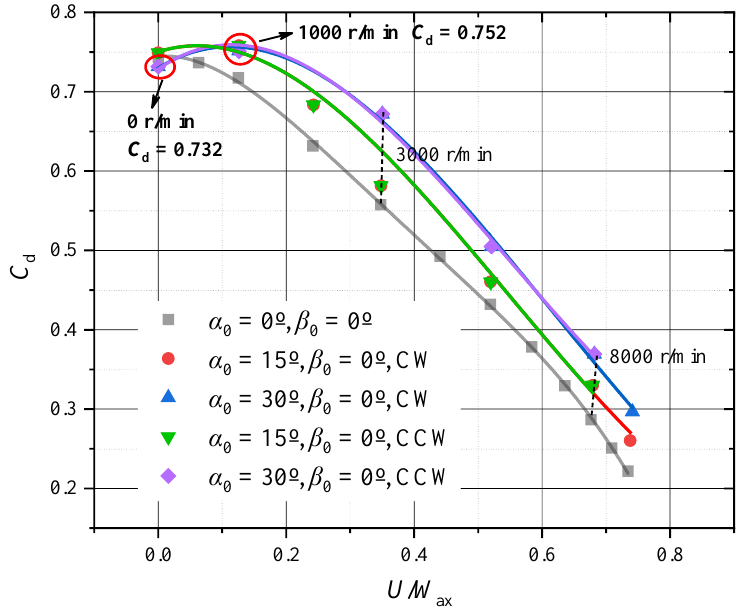
Figure 19. Relationship between C d with U/W ax under different radial inclination angles (0 ◦ , 15 ◦ , and 30 ◦ ).